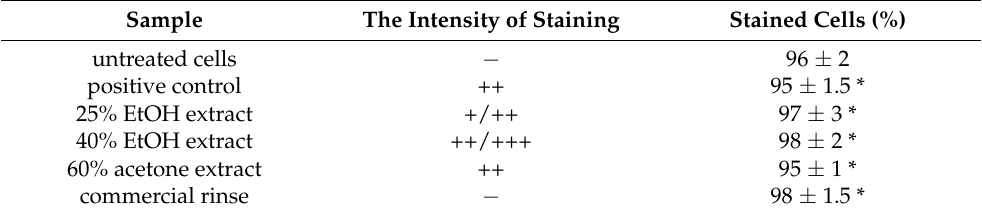
Table 2. Evaluation of the intensity of immunocytochemical reaction in human fibroblasts using antibodies against collagen type III after 24 h exposure to different extracts of Reynoutria japonica (at 50 µ g/mL) and commercial dental rinse (1.56% solution). Note that 25% EtOH, 40% EtOH, and 60% acetone means 25% ethanol extract, 40% ethanol extract, or 60% acetone extract from Reynoutria japonica rhizomes, respectively. Positive control: betulinic acid (2 µ M). Sample The Intensity of Staining Stained Cells (%)